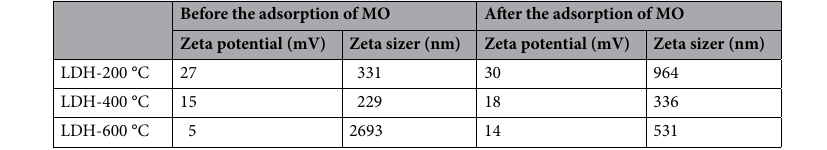
Table 2. Zeta potential and particle size of prepared